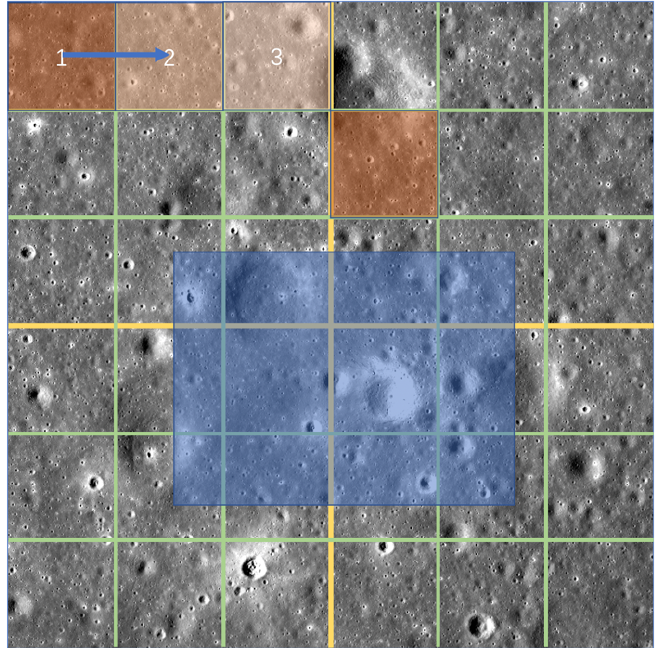
Figure 10. Decomposition diagram of impact crater detection.